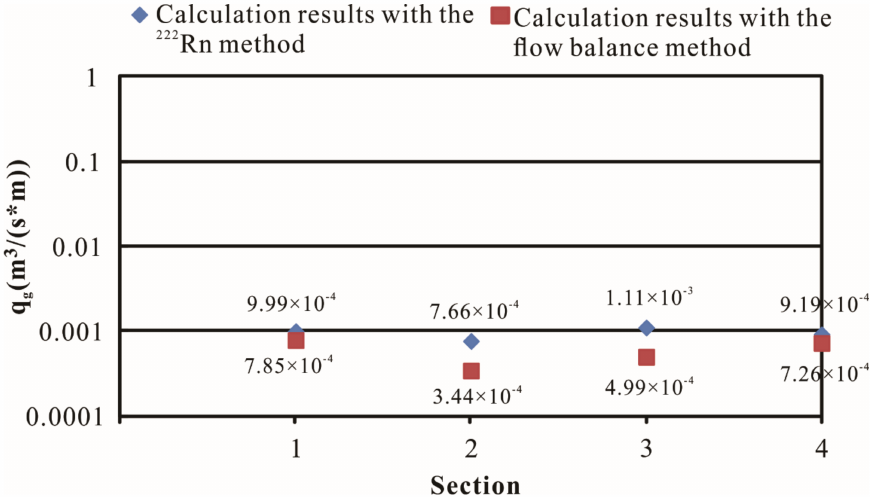
Figure 12. Comparison of calculated results of water flux using di ff erent